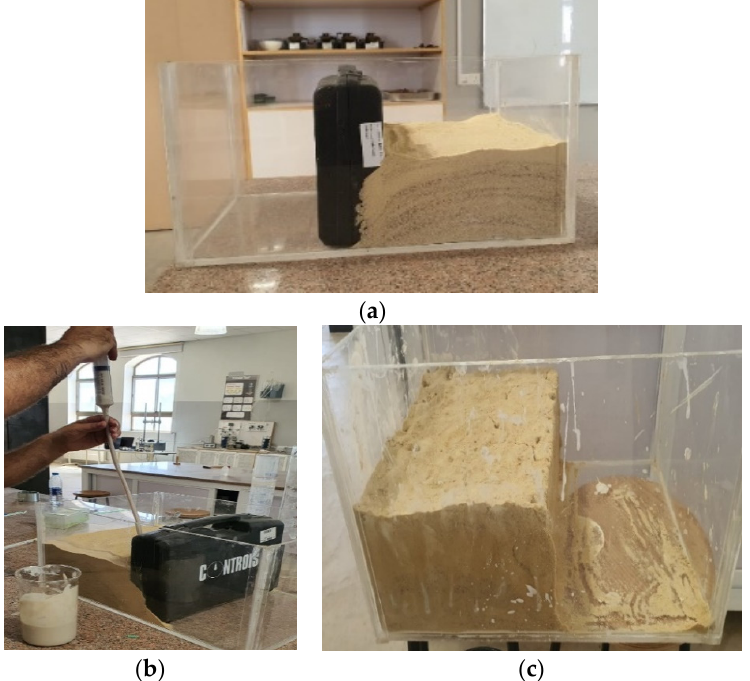
Figure 6. Box filled with sand and supported with barrier before and after injection process. ( a ) Box filled with sand and supported with barrier. ( b ) Bentonite injection process into sand. ( c ) Box filled with sand and supported with